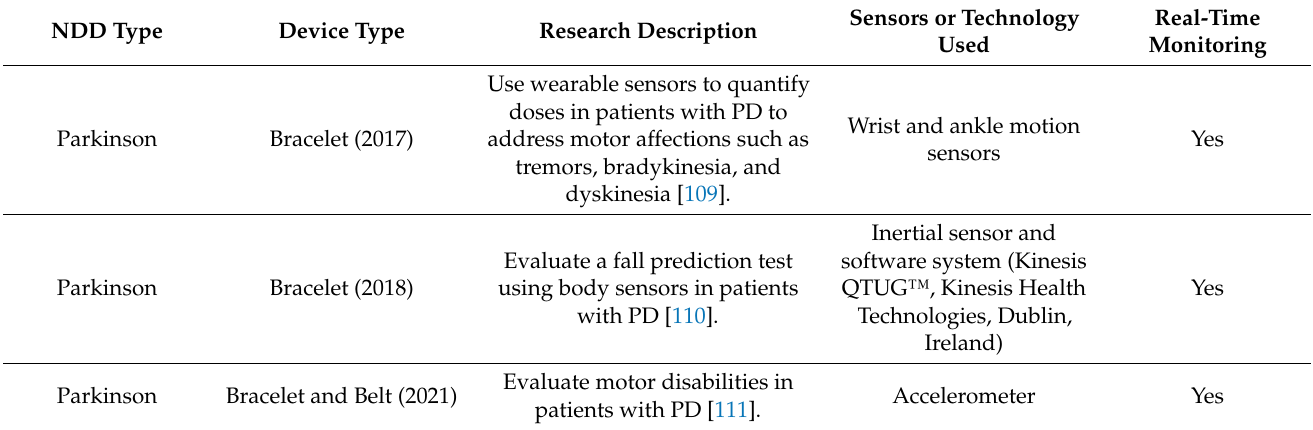
Table 5. Non-Commercial / Research Wearables for Monitoring NDD-Related Motor Impairments. NDD Type Device